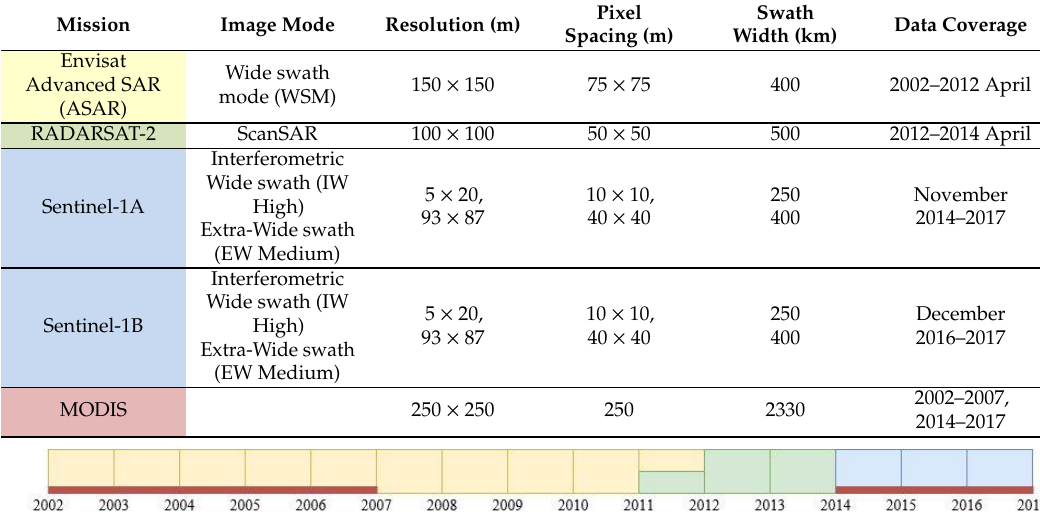
Table 1. The list and technical characteristics of Earth observation (EO) missions used for the analysis of the ice cover in the Curonian Lagoon. Colors mark specific data sets used during the study period and shown at the bottom of the table, the underlying red lines indicate the available moderate resolution imaging spectroradiometer (MODIS) images.